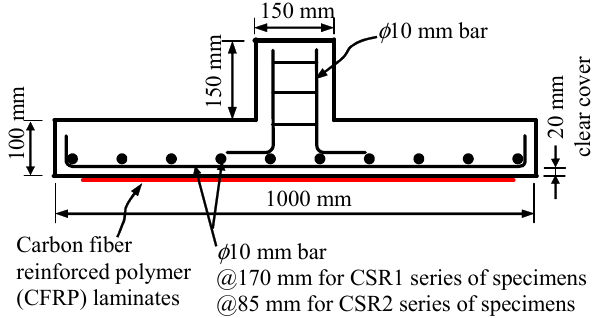
Figure 1. Test Figure 1. Test specimen.